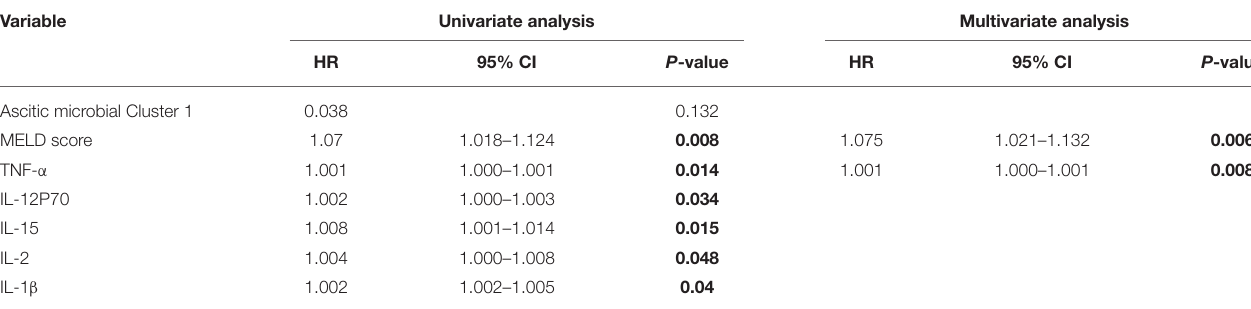
TABLE 2 | Cox regression analysis for variables and 90-day